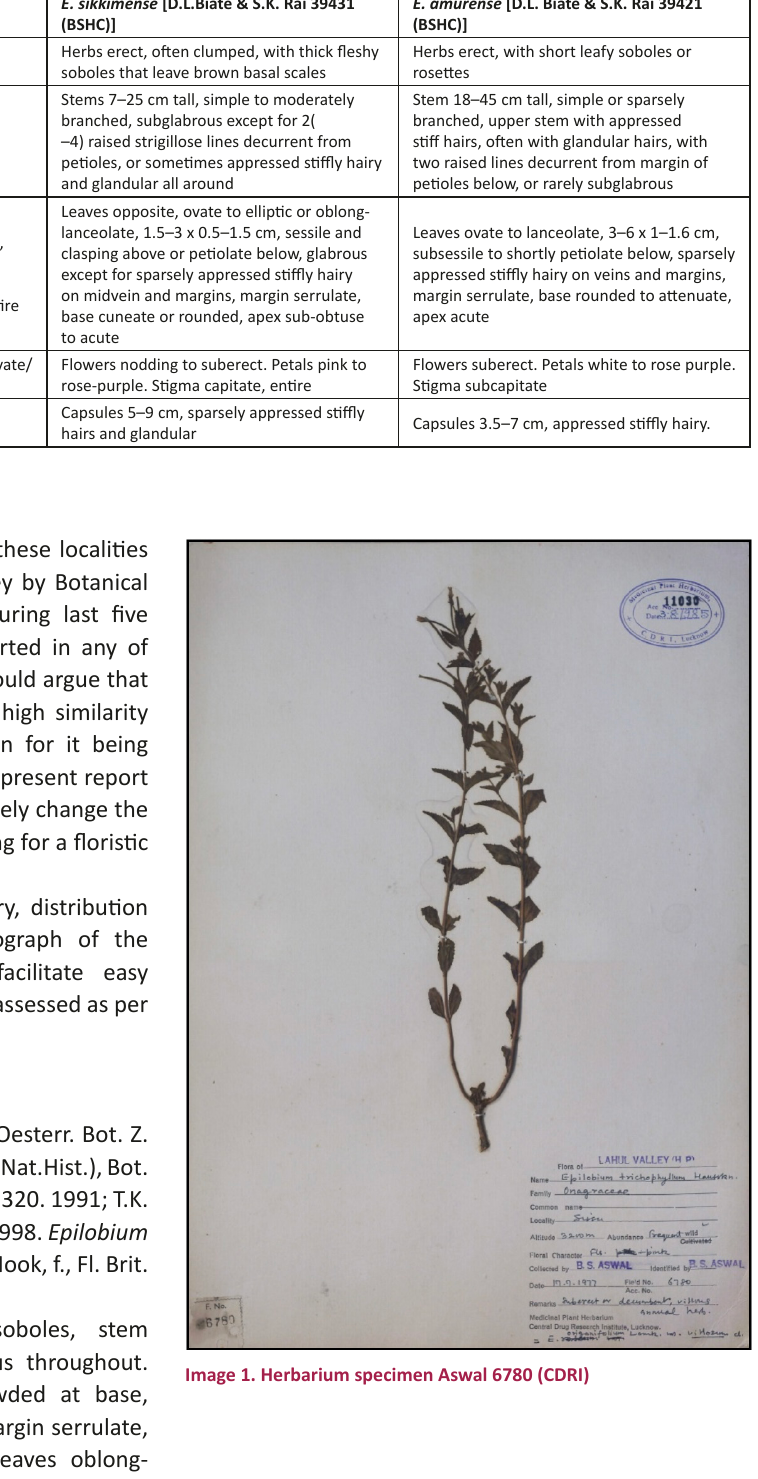
Table 1. Comparative morphology of Epilobium trichophyllum , E. sikkimense , and E. amurense. Species